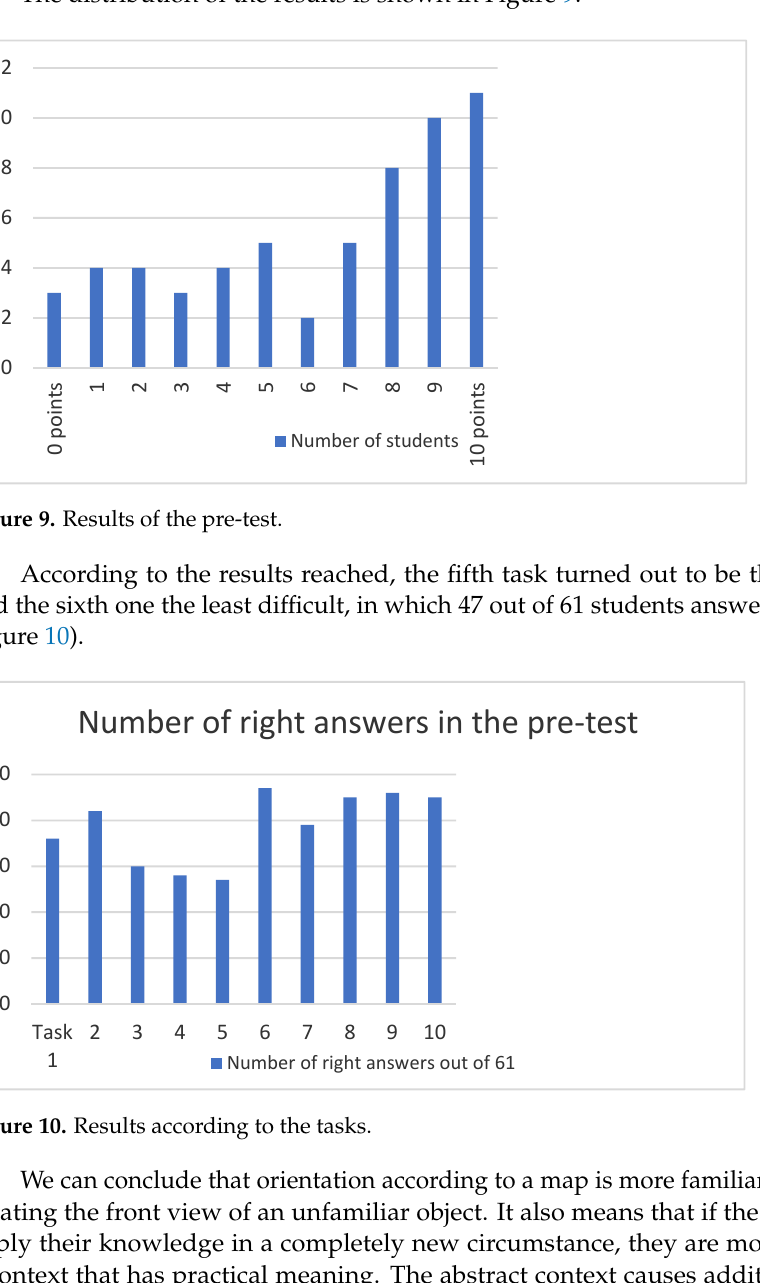
Figure 8. Assignment of Task 7.